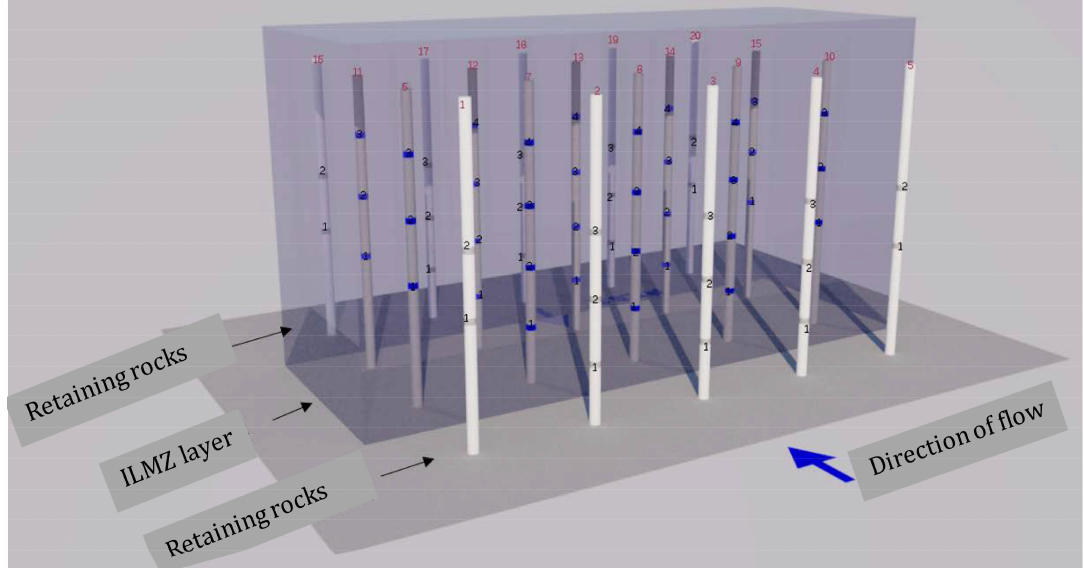
Figure 1. Schematic illustrate of the monitoring wells installed in the PRW. The numbers in black font on each well show the sampling port elevation with 1 at 0.5 m above the bottom. The numbers in red denote the sample wells in